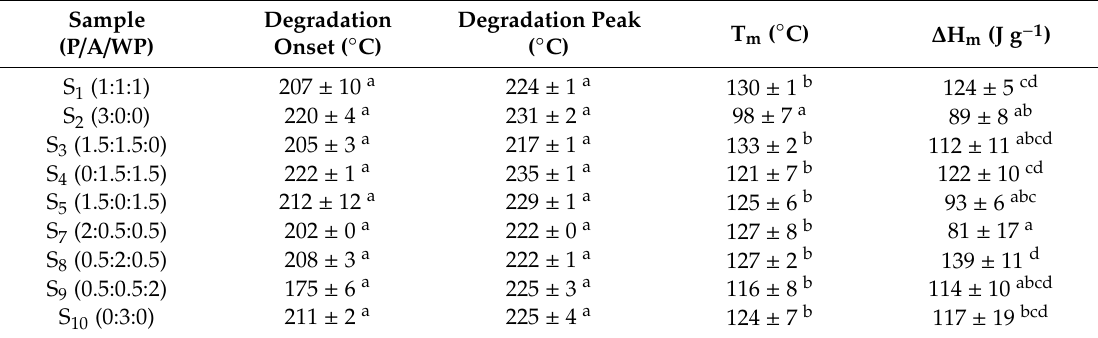
Table 7. Di ff erential scanning calorimetry and thermogravimetric data for edible films. Table 7. Differential scanning calorimetry and thermogravimetric data for edible films.